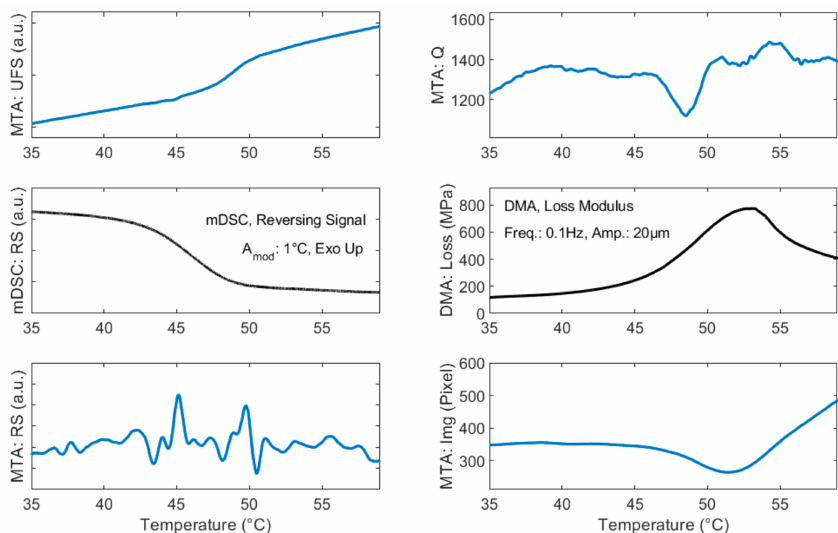
Figure 7. Comparison between MTA signals (in blue) and conventional techniques (in black). All x-axes are linked and represent temperature ( ◦ C) as indicated at the bottom of the figure. All measurements were performed with a heating rate of 1.6 ◦ C /